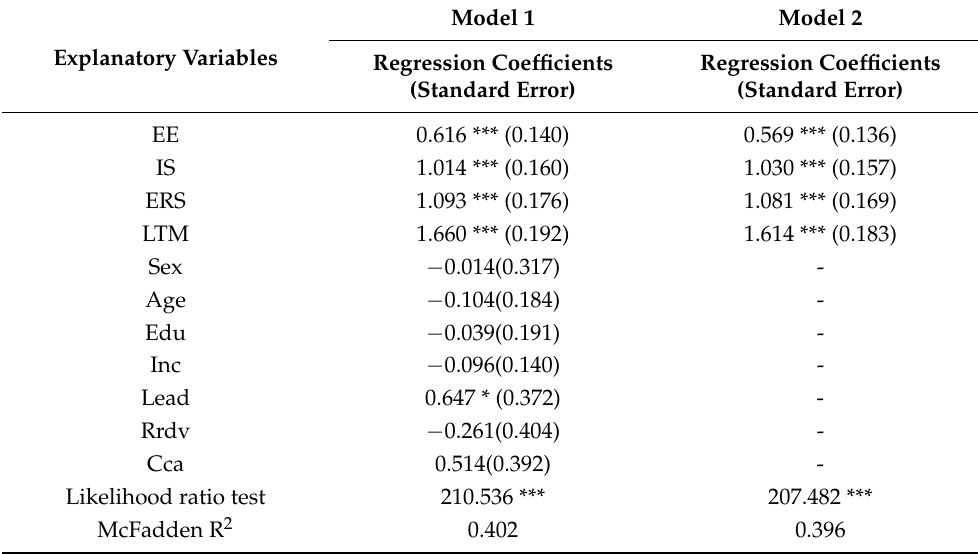
Table 5. Regression results of ordered logistic model.